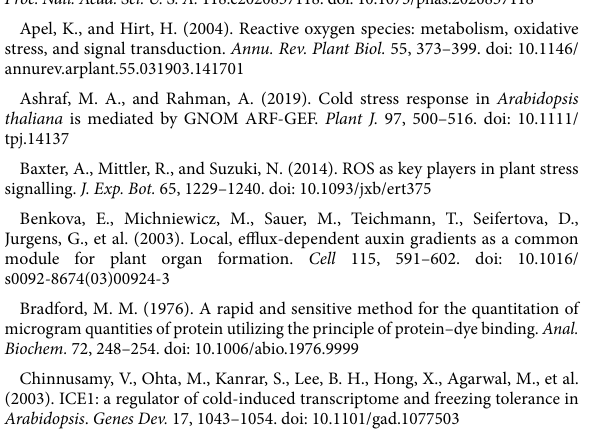
SUPPLEMENTARY FIGURE 1 Comparison of phenotype between WT and ospin9 mutants in rice at the seedling stage. (A) Phenotype of WT and ospin9 mutants after germination for 7 days. Bar = 3 cm. (B) Phenotype of WT and ospin9 mutants after germination for 14 days. Bar = 3 cm. Values are means ± standard deviation (SD; n = 12). Data were analyzed by ANOVA and Tukey’s tests at p < 0.05 significant